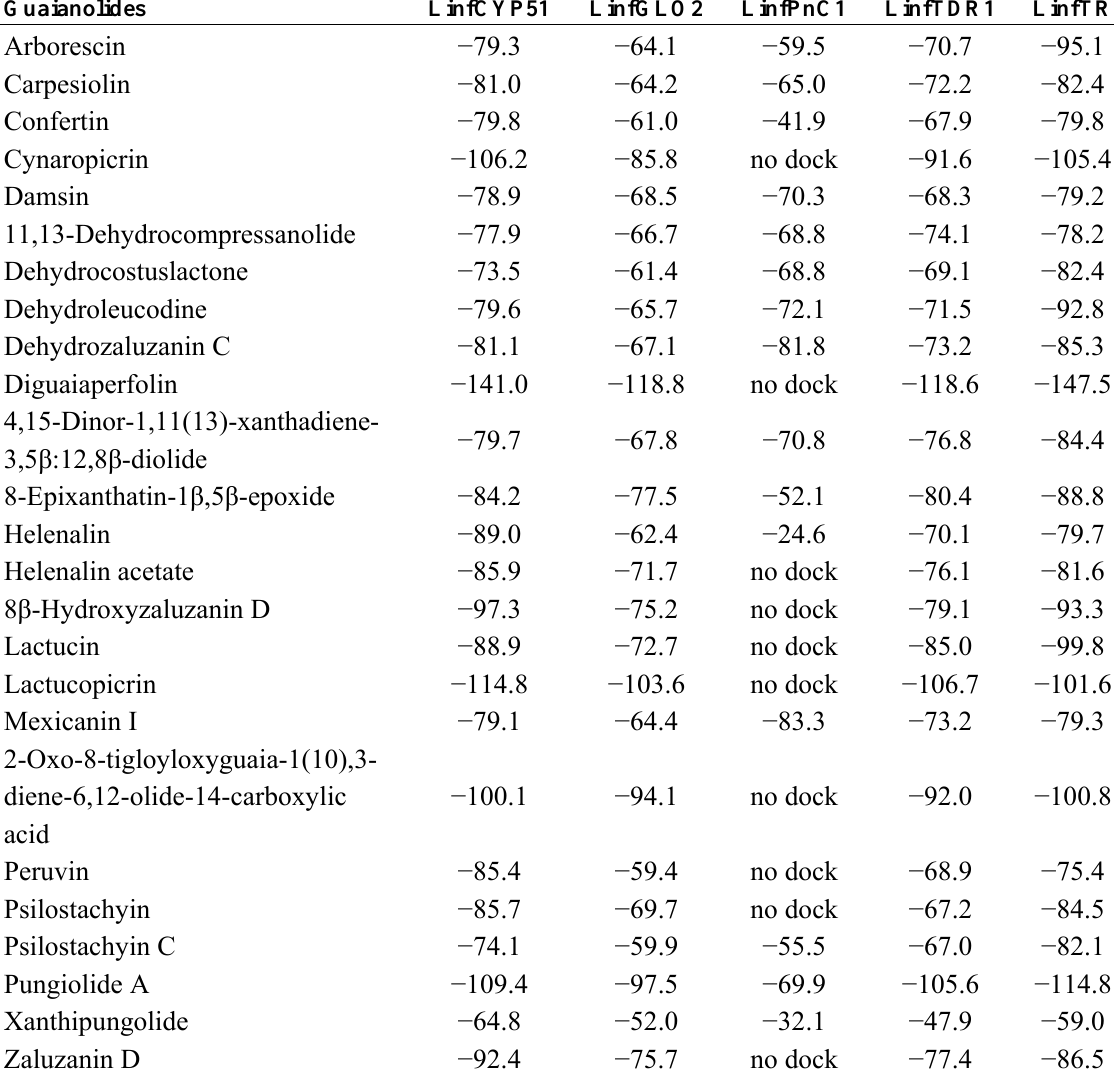
Table 9. MolDock docking energies (kJ/mol) of guaianolide sesquiterpenoids with Leishmania infantum protein